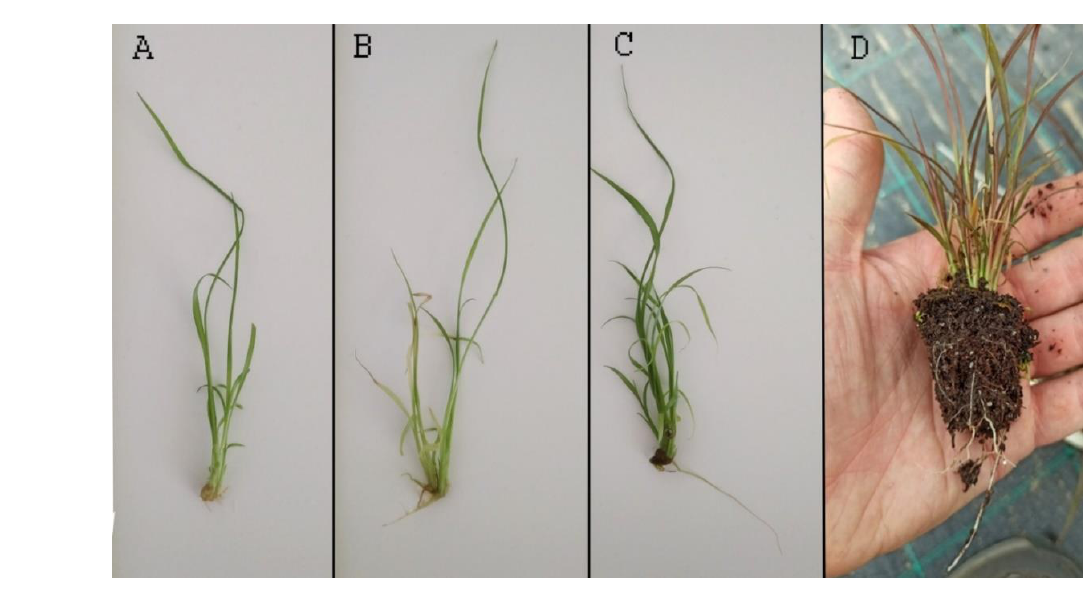
Figure 2. Effect of rooting medium and acclimatization. ( A ). Roots obtained on R1 after 3 weeks. ( B ). Roots obtained on R2 after 3 weeks. ( C ). Roots obtained on R3 after 3 weeks. ( D ). Acclimatized plant.